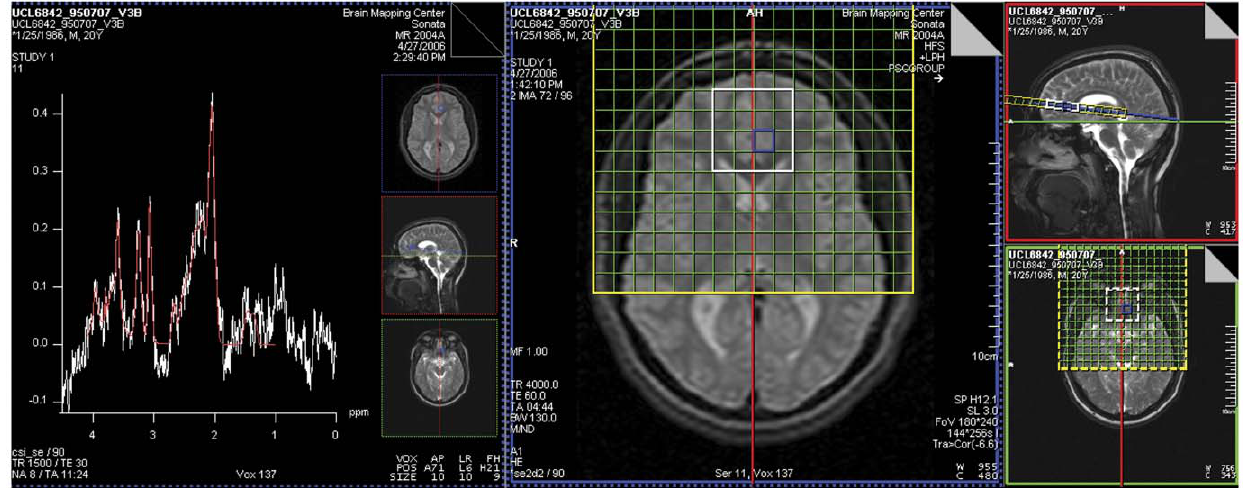
Figure 4. ( Rightthreepanels ) MRI sections showing positioning of axial-oblique ( parallel to genu-splenium line in sagittal plane ) proton magnetic resonance spectroscopic imaging ( 1 H MRSI, TR/TE =1500/30 ms ) slab ( greengrid ) . The PRESS acquisition volume ( white box ) sampled bilateral pregenual anterior cingulate cortex (pACC, posterior mesial voxels), mesial superior frontal cortex (anterior mesial voxels) and laterally adjacent white matter (lateral voxels). ( Left panel ) sample spectrum from left pACC voxel selected in blue. The white trace depicts the